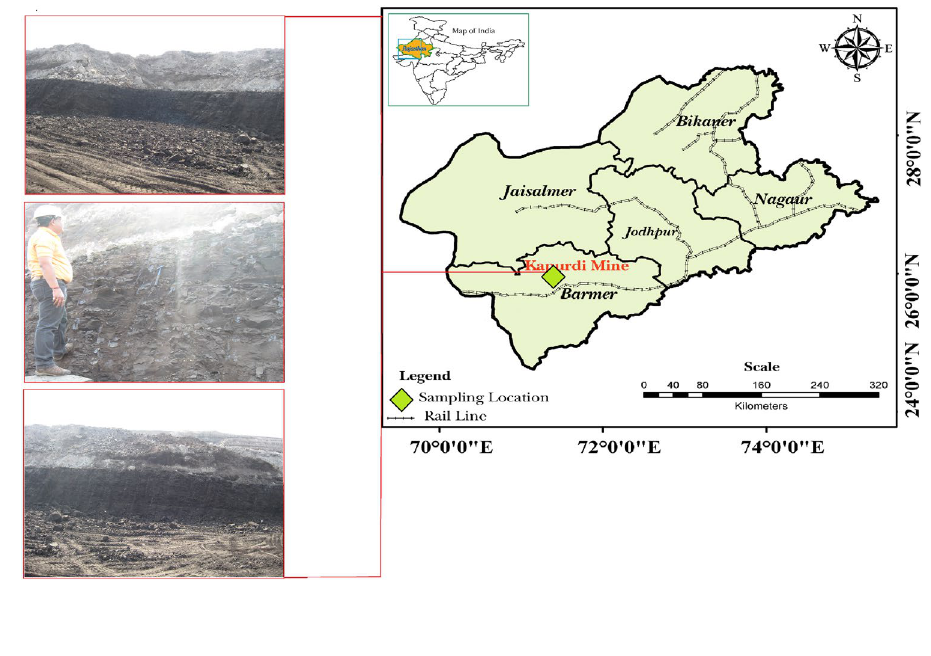
Fig. 1 Right: Location map of the main basin in the Rajasthan, northwestern India, showing the Kapurdi mine location in the Barmer Basin and Left: Pho- tomicrographs of the outcrop section in the Kapurdi mine